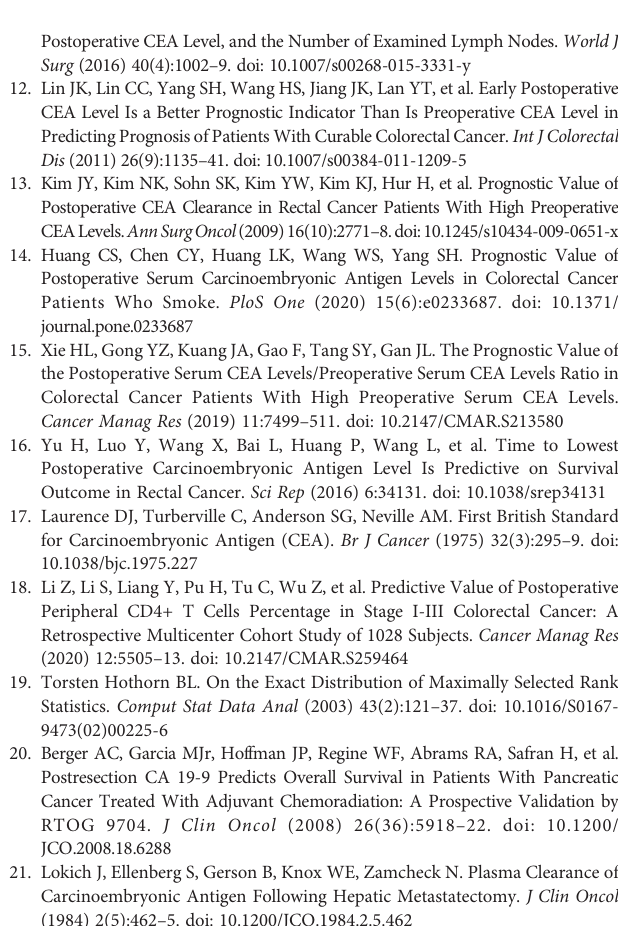
Supplementary Figure 2 | Theoptimalcut-offto CEAashigh-recurrenceriskand low-recurrenceriskpatientwasdeterminedbymaximallyselectedrankstatisticsmethod. Supplementary Figure 3 | Kaplan-Meier survival curves of RFS of CEA-low vs CEA-high categories in the sensitivity analysis population. CEA-low: CEA post-m2 – 3